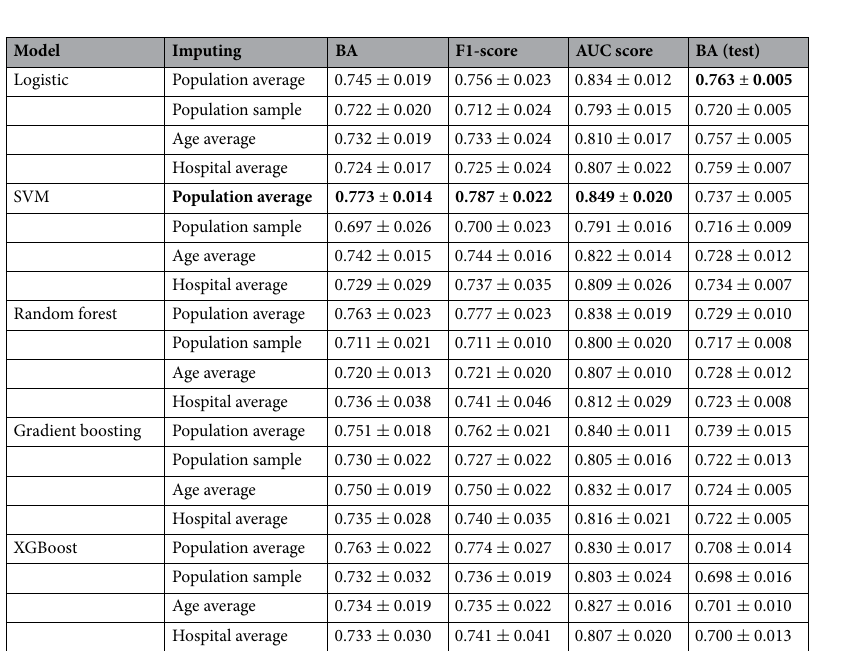
Figure 5. Compared to Fig. 4 NN precision here stands for our image + meta model which shows great agreement with the baseline models, even more so, (in most cases) than the baselines agree with each other, this is also reflected by the Cohen-kappa 31 scores.